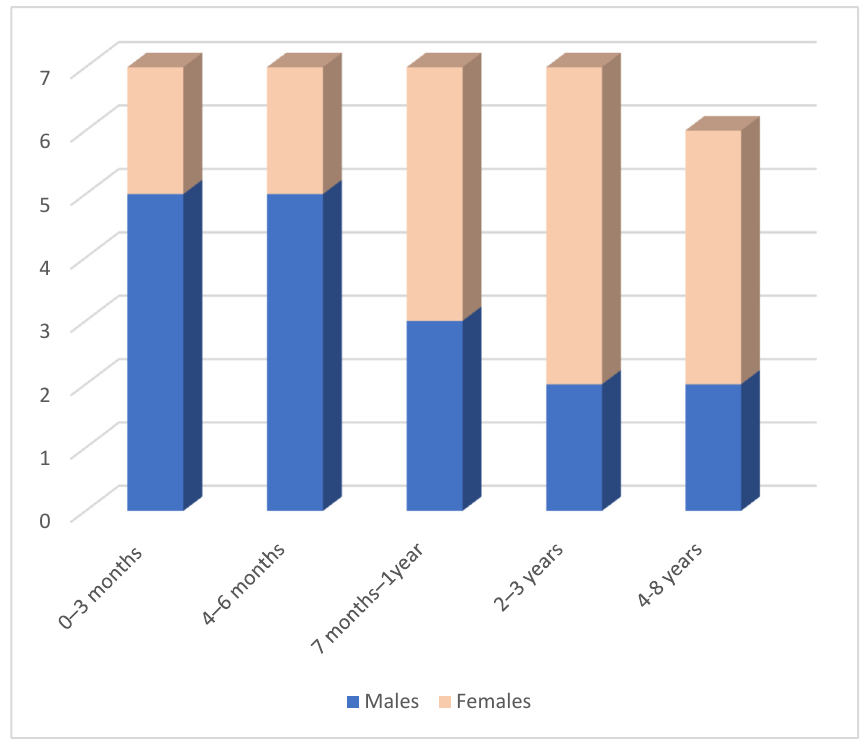
Figure 1. Sample distribution by sex and age.